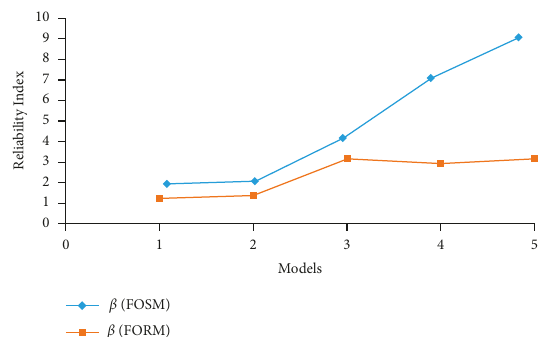
Figure 17: Comparison of reliability indices of FOSM and FORM methods in models. Figure 18: Possibility of failure in models.